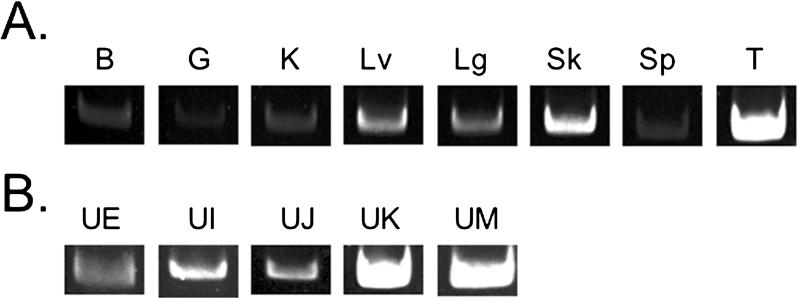
RT-PCR Results Demonstrating Class I Expression(A) RT-PCR results demonstrating Class IUA1 expression in brain (B), gut (G), kidney (K), liver (Lv), lung (Lg), skin (Sk), spleen (Sp), and thymus (T).(B) RT-PCR results demonstrating expression of Class IUE, UI, UJ, UK, andUM in the thymus.Similar results were found forUG (not shown). Controls (water) were negative for all primer combinations (not shown).